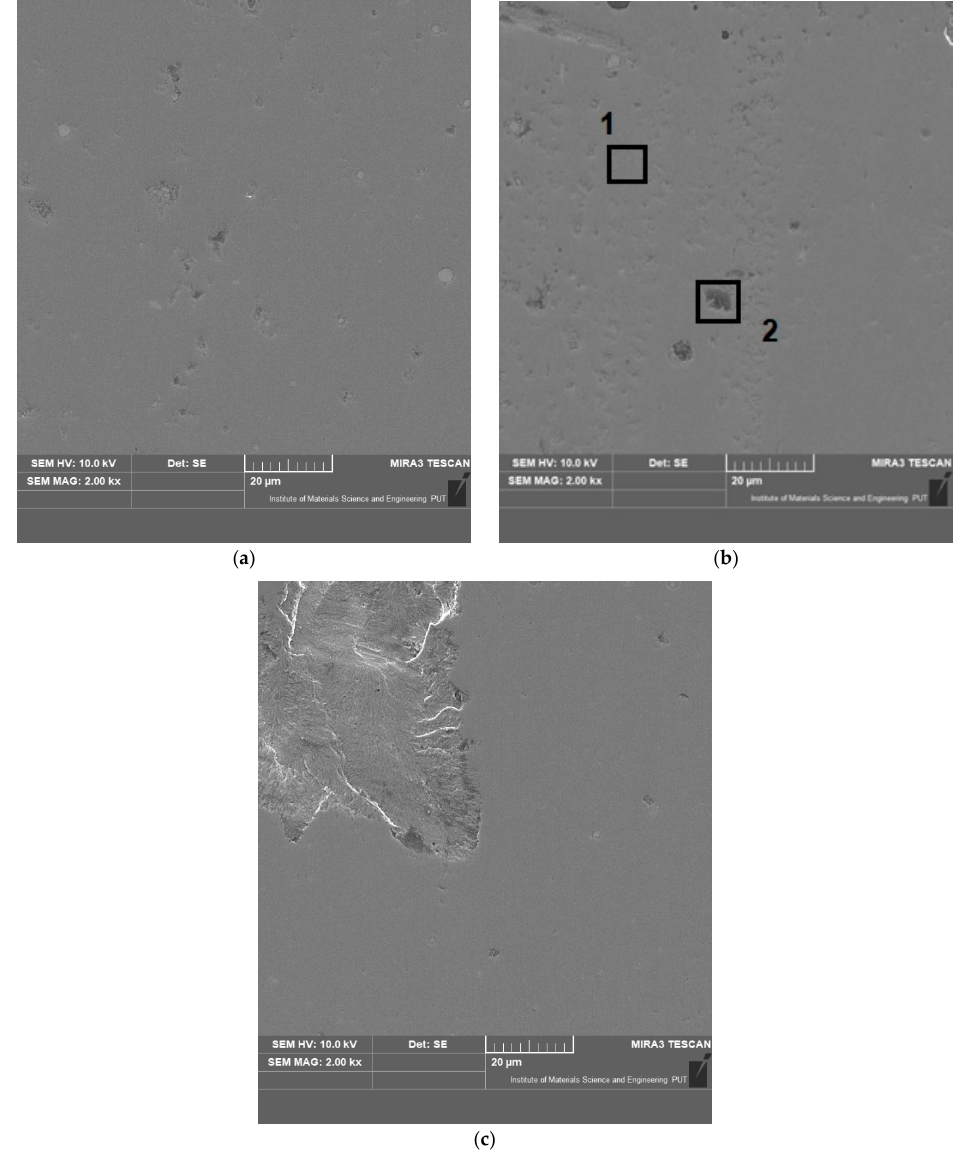
Figure 10. Pictures of the wear trace surface for Cr/CrN PVD coating at an open circuit potential, E OCP , under specific loads: ( a ) 9 N, ( b ) 13 N, ( c ) 19 N.